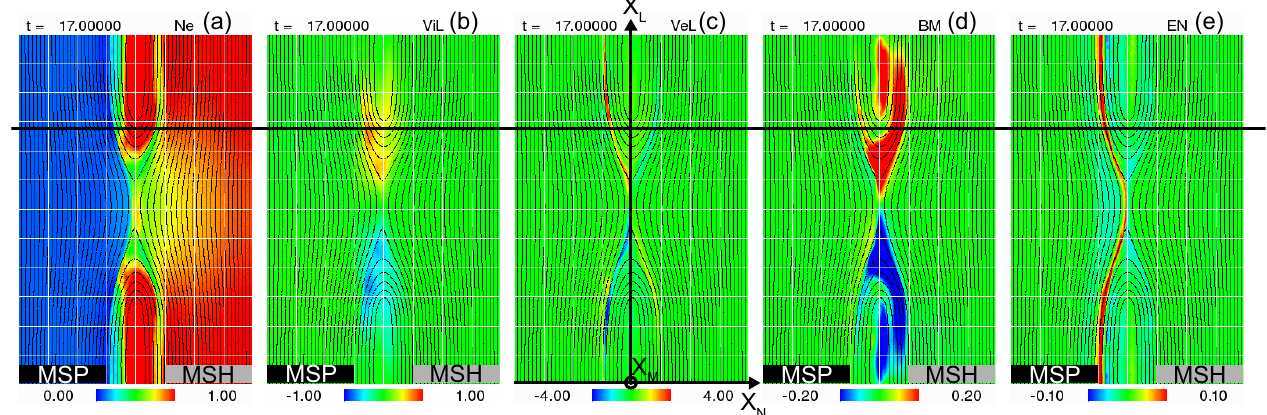
Fig. 4. 2-D color contours of the simulation results at t =17. (a) The electron number density n e , (b) the ion outflow bulk velocity V iL , (c) the electron outflow bulk velocity V eL , (d) the out-of-plane magnetic field B M , and (e) the normal component of the electric field E N . The bands at the bottom of each panel show the MSP and MSH domain in the simulation box. The horizontal black line shows the virtual spacecraft observation path, along which detailed analysis is made in Fig.